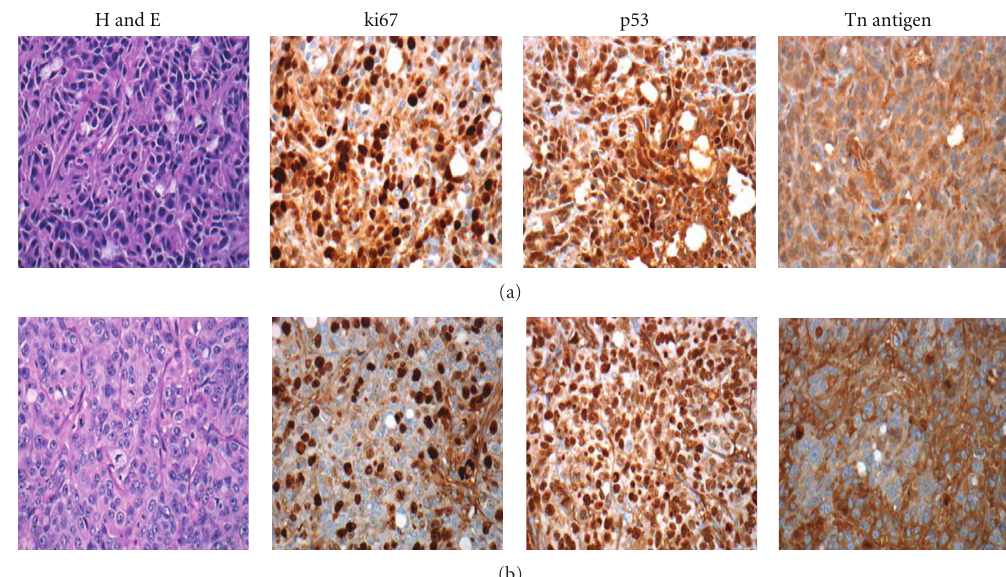
Figure 8: Interference examination of AQD-Tn mAb probe on standard pathological evaluations. (a) Control tumors; (b) AQD-treated tumors. Di ff erent markers were evaluated such as Tn antigen, p53, and ki67. No interference with the following pathological examination was